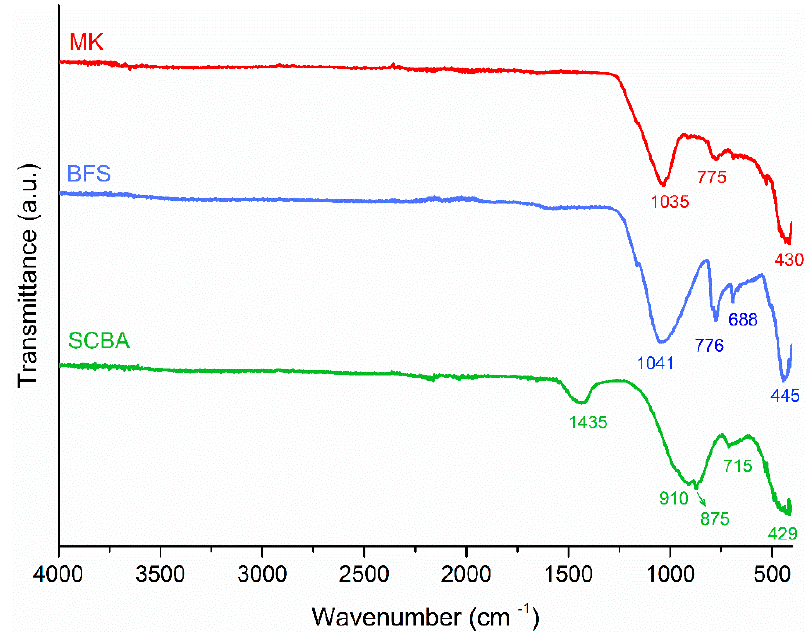
Figure 12. FTIR image spectra of MK, BFS and SCBA.